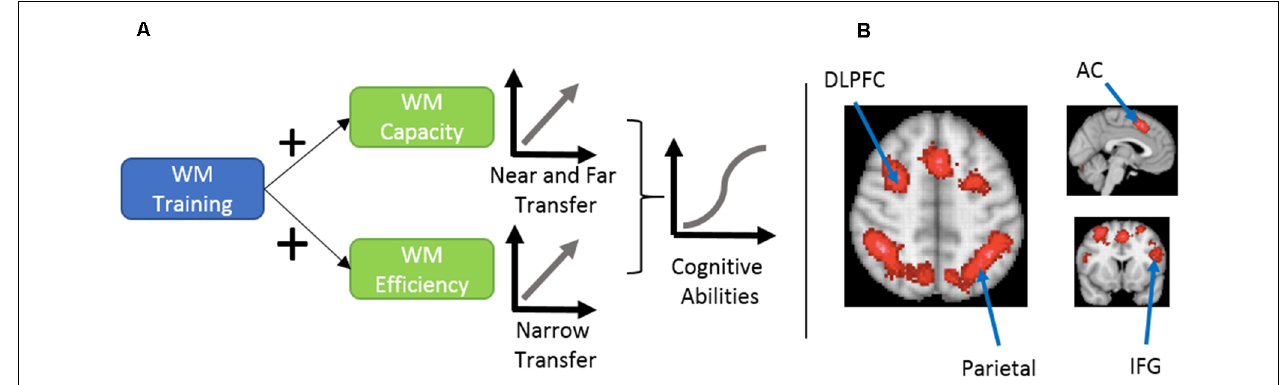
FIGURE 1 | (A) Proposed mechanism of cognitive ability enhancement using working memory training, as explained by von Bastian et al. (2013). (B) An association-test map displaying brain regions that were consistently reported in 1091 studies investigating working memory. Working memory training engages executive and dorsal attentional networks. This involves brain regions like dorsolateral prefrontal cortex (DLPFC), anterior cingulate (AC), inferior frontal gyrus (IFG), and parietal regions. Map prepared using Neurosynth meta-analysis of the term working memory (Yarkoni et al., 2011). Similar neural networks show decreased signals in attention deficit hyperactivity disorder (ADHD) patients performing working memory